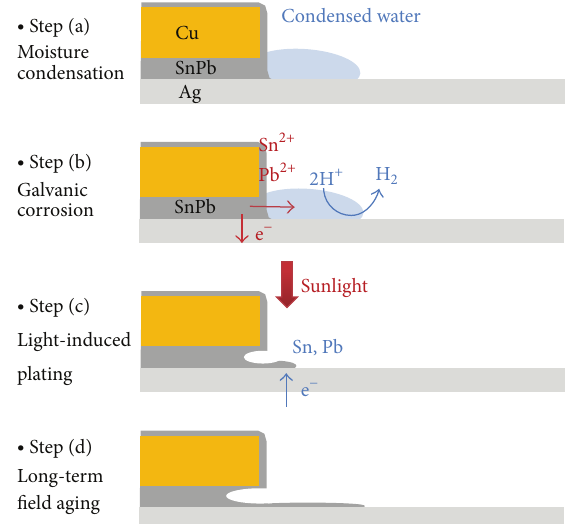
Figure 6: Schematic of mechanism by the Sn and Pb layers formed on the Ag